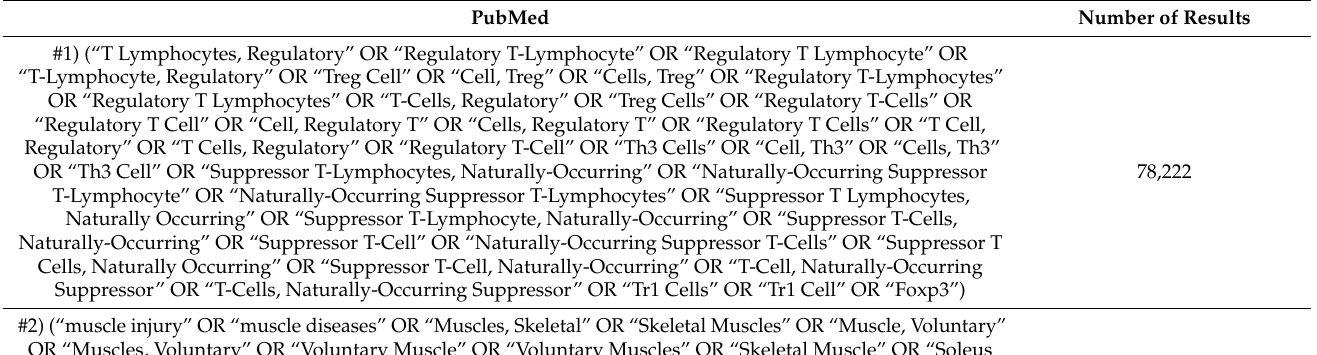
Table 1. Search strategy for studies published from the beginning of the database up to 23 April 2021.